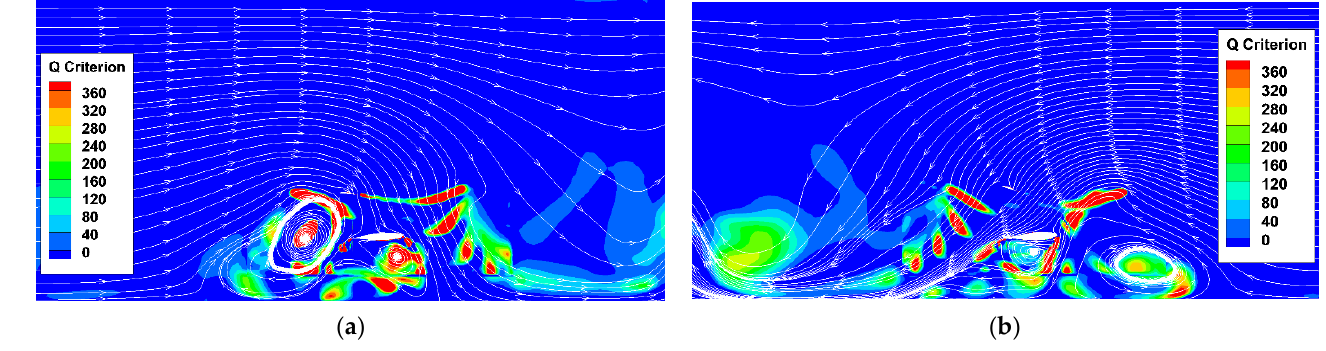
Figure 15. Side-view slices of the iso-surface of the Q-criterion at 0.5R: ( a ) τ = − 5°; ( b ) τ = +5°.